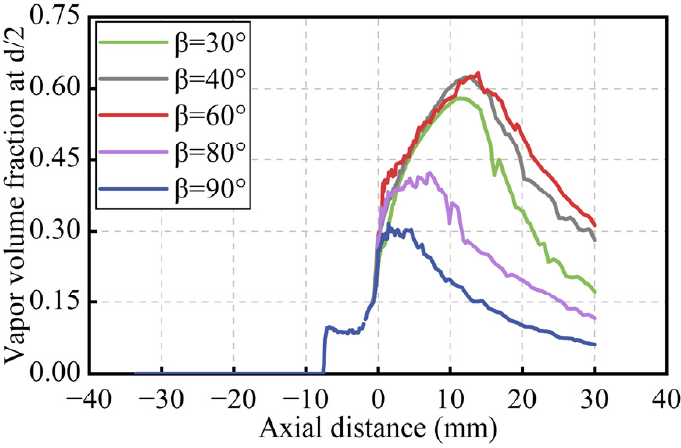
Figure 21. Effect of β on the cavitation.